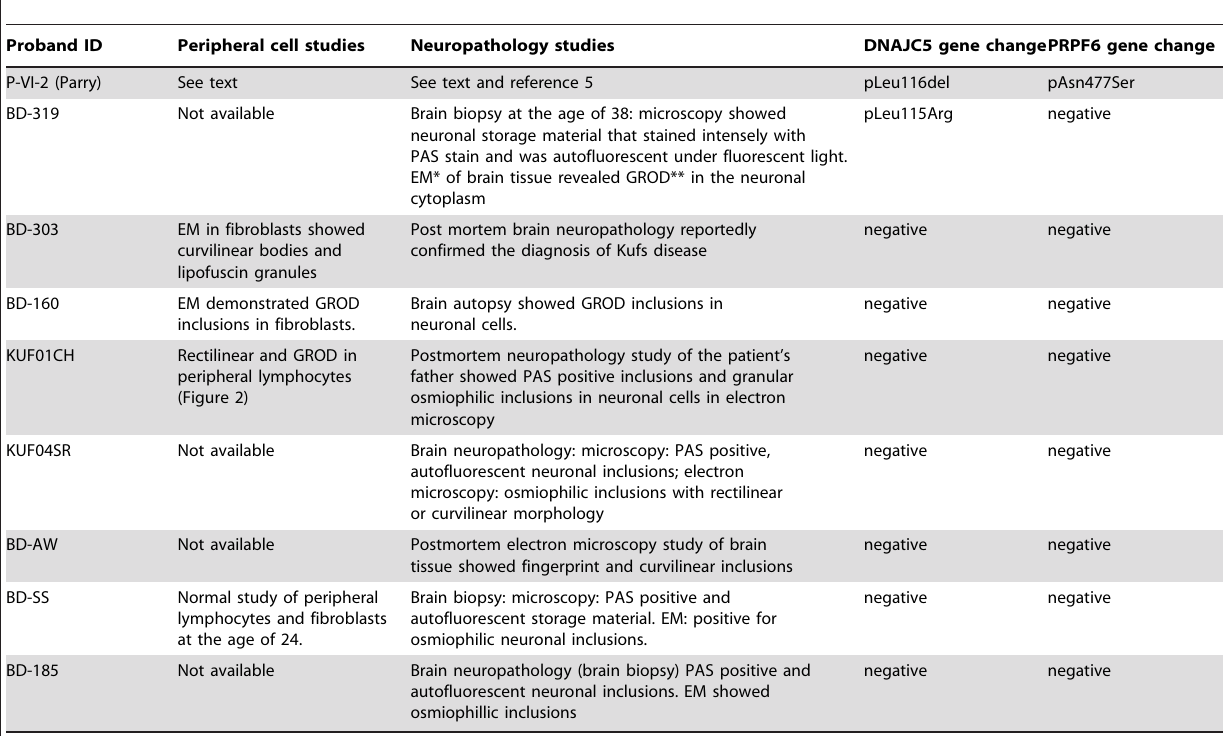
Table 2. Laboratory, neuropathology studies and DNAJC5 mutation status of probands from the families included in the study.